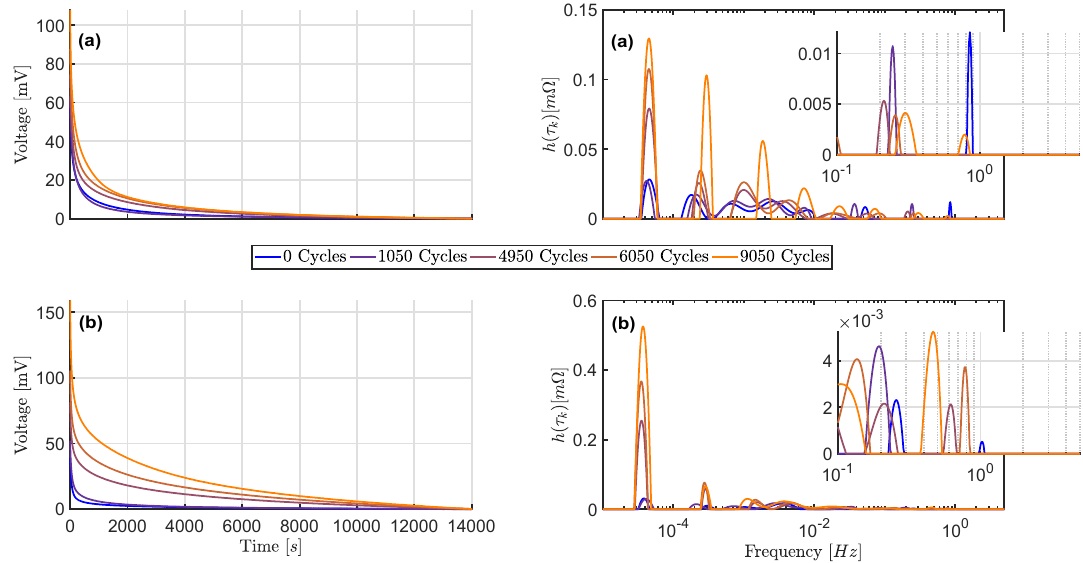
Figure 8. Measured voltage relaxation and derived DRTs over aging ( a ) At 20% SOC; ( b ) At 80% SOC. The voltage courses show a slowdown of the relaxation process as aging